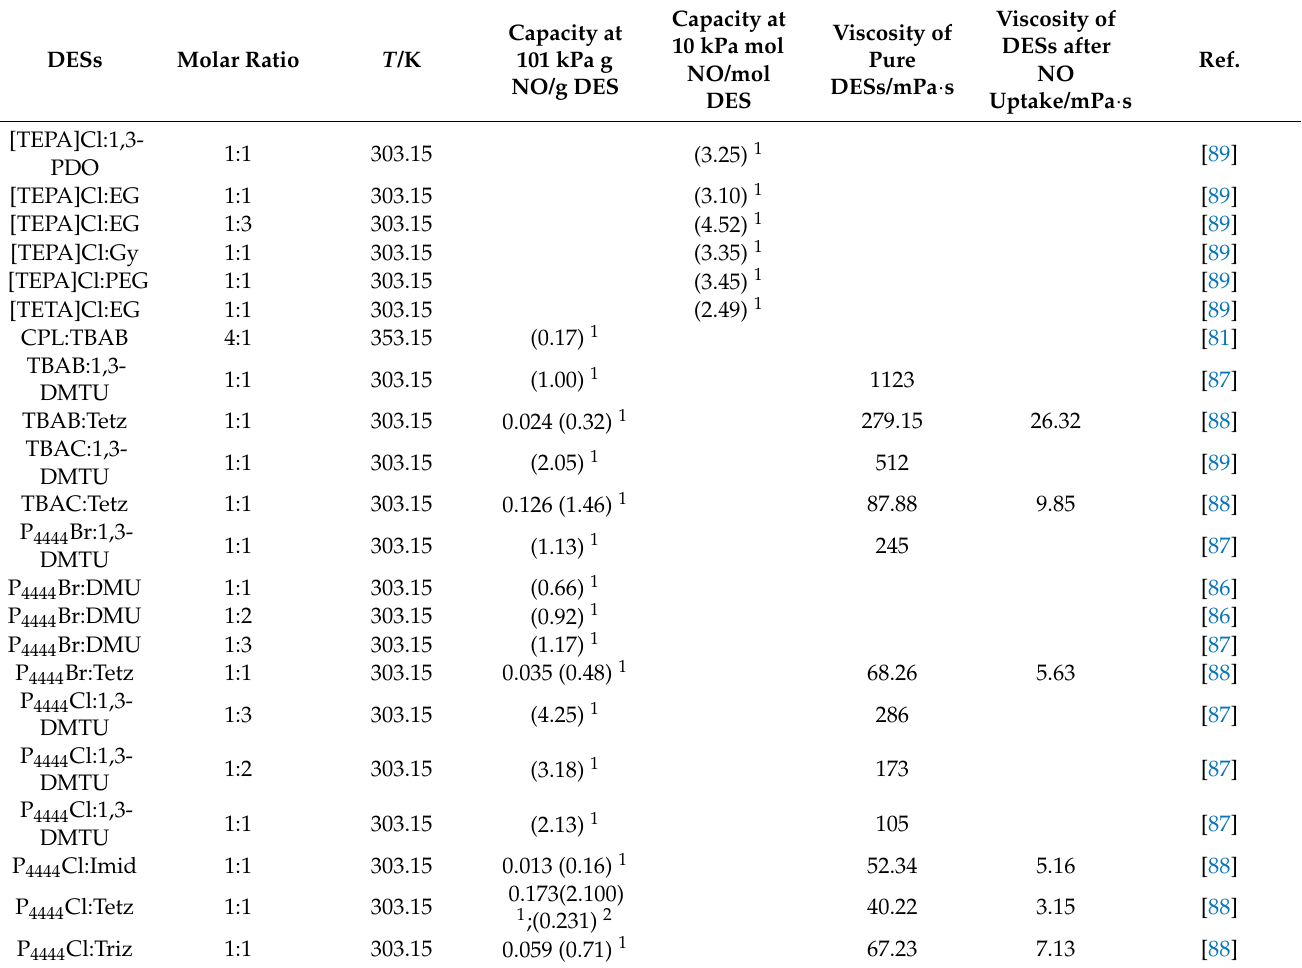
Table 5. NO solubility in functionalized